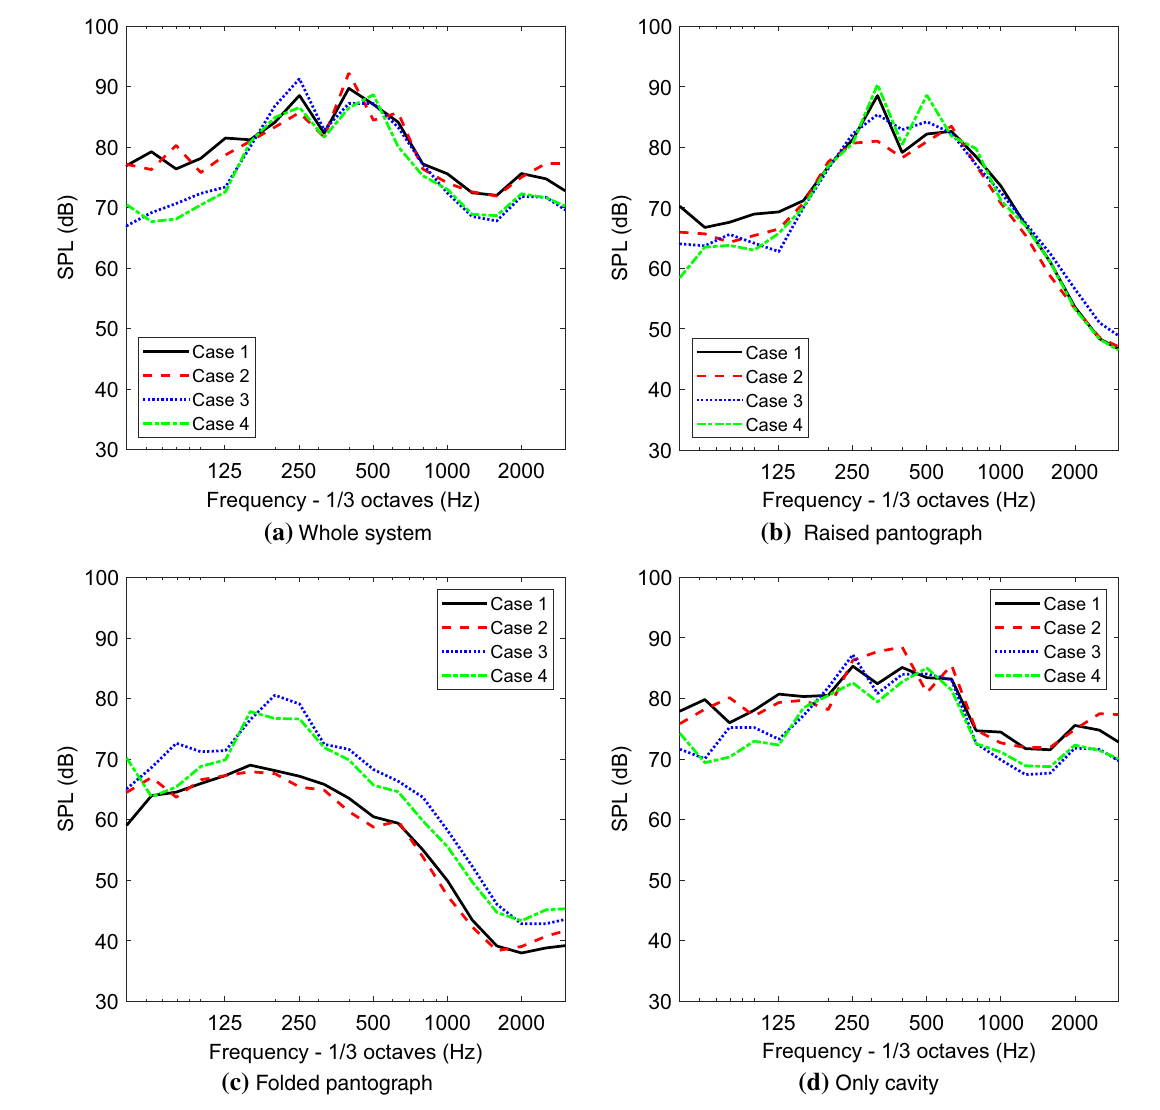
Fig. 17 Sound pressure levels at top receiver